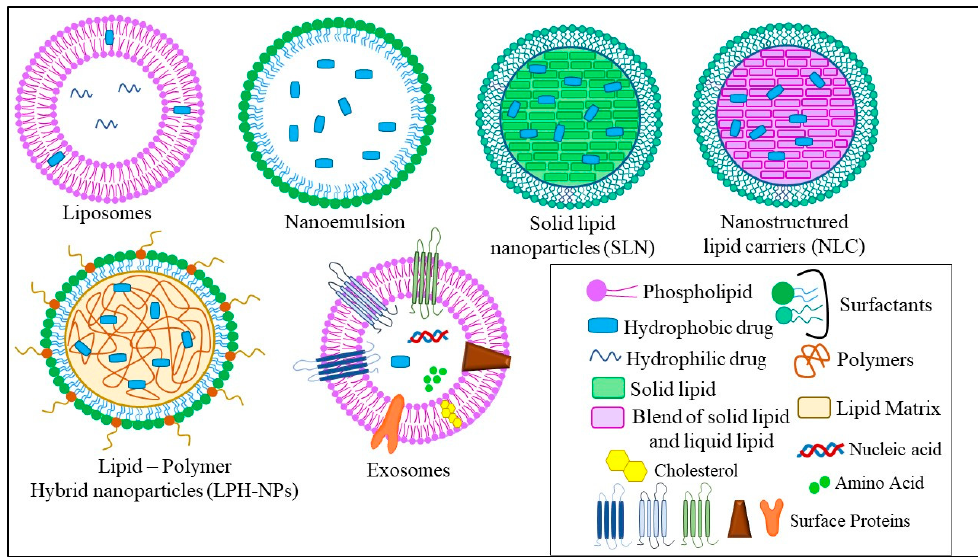
Figure 2. Different types of LNPs used for the treatment of TNBC. Table 2. Various types of lipid-based nanoparticles (LNPs) employed for the treatment of TNBC .